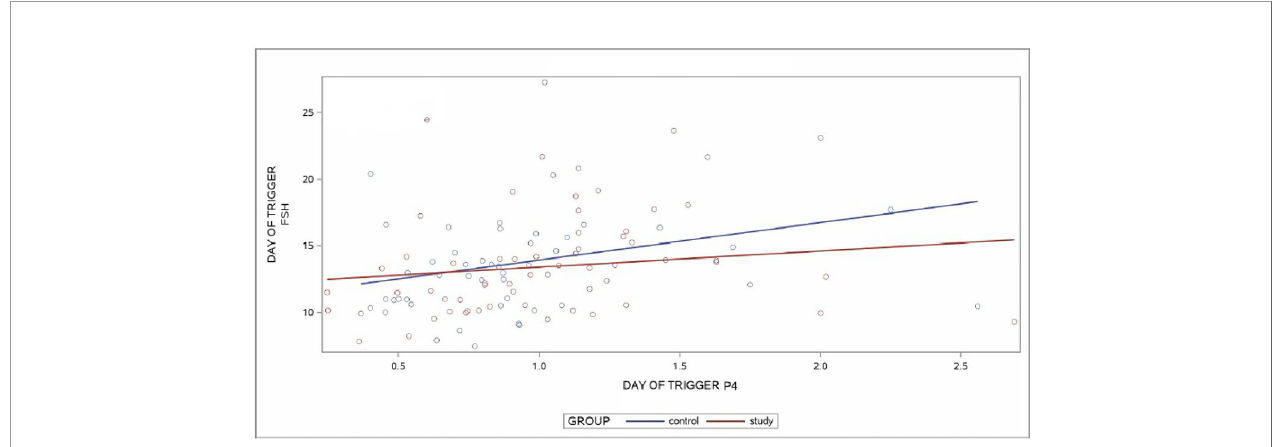
FIGURE 3 | Regression lines of control group (CG) and study group (SG) for the relationship between day of trigger (DoT)-FSH and day of trigger (DoT)-P4 levels. FSH, Follicle Stimulating Hormone; P4,